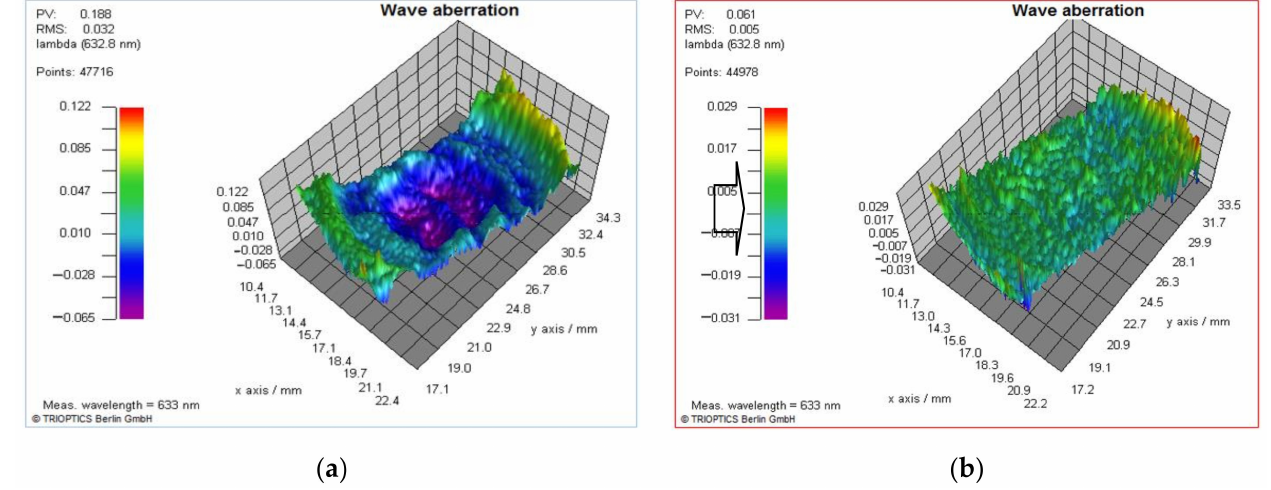
Figure 17. The measured wavefront with ( a ) mono-LUT method and ( b ) PCM method.